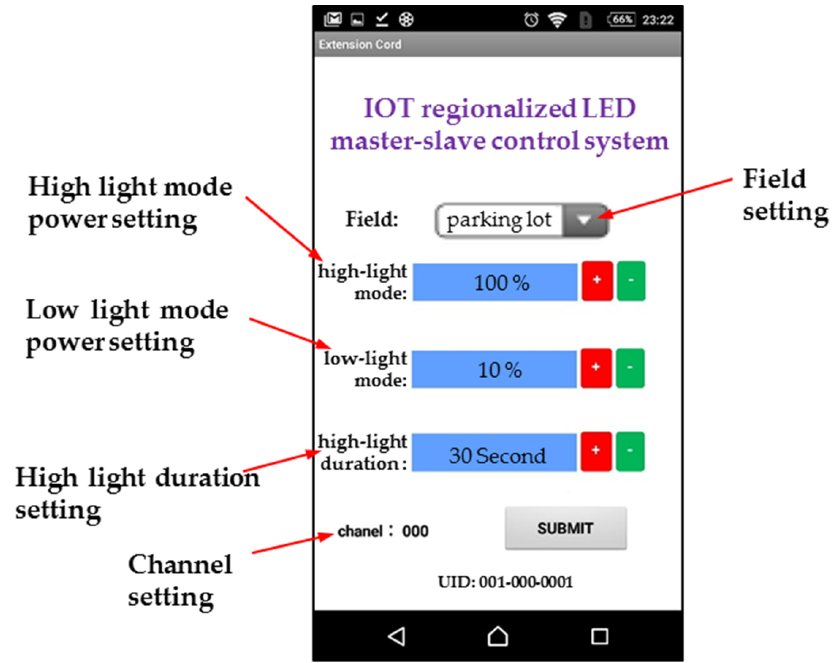
Figure 10. Setting screen of our developed mobile device app for the proposed IoT-based intelligent LED light. LED